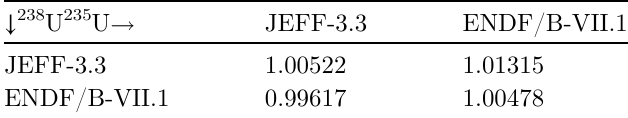
Table 2. Comparison of k calculation for imf7 by eff mixing the sources of the evaluations for 235 U and 238 U. In all cases, the probability tables are included. The statistical uncertainties are about 25 pcm. The reported k eff in the ICSBEP database is